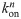
Ensemble of coupled myosin heads.(a) A simplified ensemble model for determining the average number of myosin heads bound to the actin filament. Each of the N myosin heads can either bind to the filament with binding rate kon or unbind with unbinding rate koff. The system can be described as a finite Markov chain in which each state is associated with the number of bound myosin heads. The transition rates konn and koffn between these states are effective rates that depend on the number n of bound myosin heads. (b) The average number of bound myosin heads for an ensemble of N = 30 myosin molecules for a cooperative model (blue, solid line) in which the force per molecule f = F/n is the total external force F divided by the number n of bound myosin heads. In the two non-cooperative models (red and yellow solid lines) the force per molecule is either constant, f = F/N, or varies according to f=F/〈n˜〉, in which 〈n˜〉 is an estimated average number of bound motors. The results of a full Monte Carlo simulation of 30 elastically coupled myosin heads are shown as the broken lines for two different coupling stiffnesses: κ = 200 μN/m (orange, broken line) and κ = 500 μN/m (green, broken line).